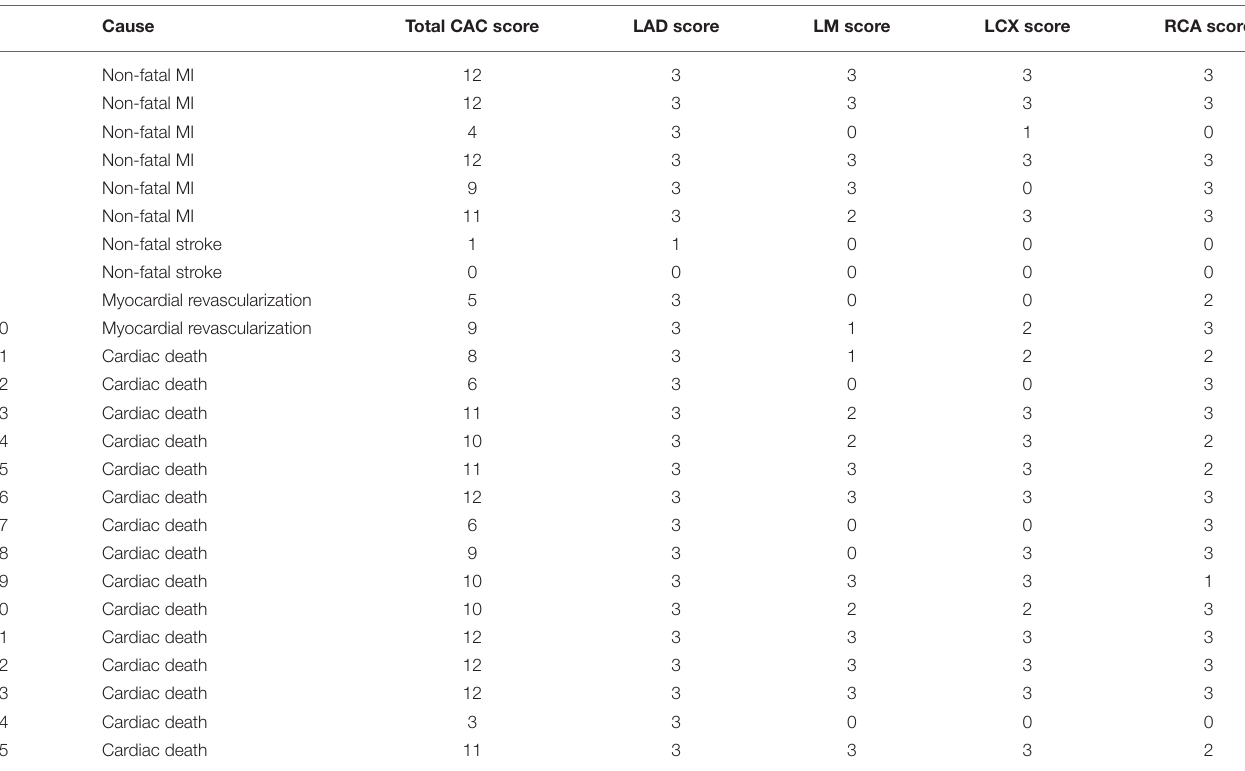
TABLE A1 | CAC scores in patients with major adverse cardiovascular